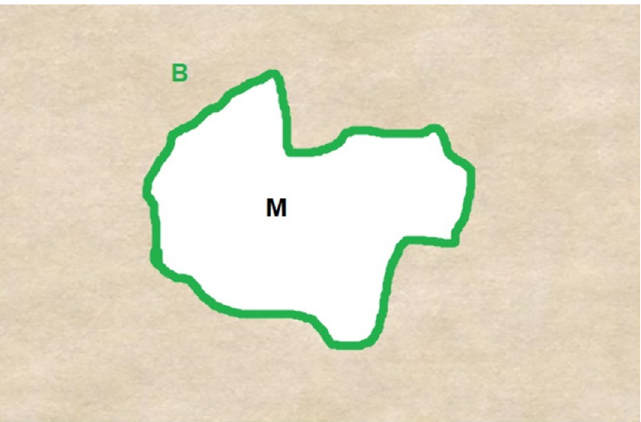
Fig 1. Gaussian conditional inpainting: Estimating the missing pixels value in M from the conditioning pixels in the set B located at the border.